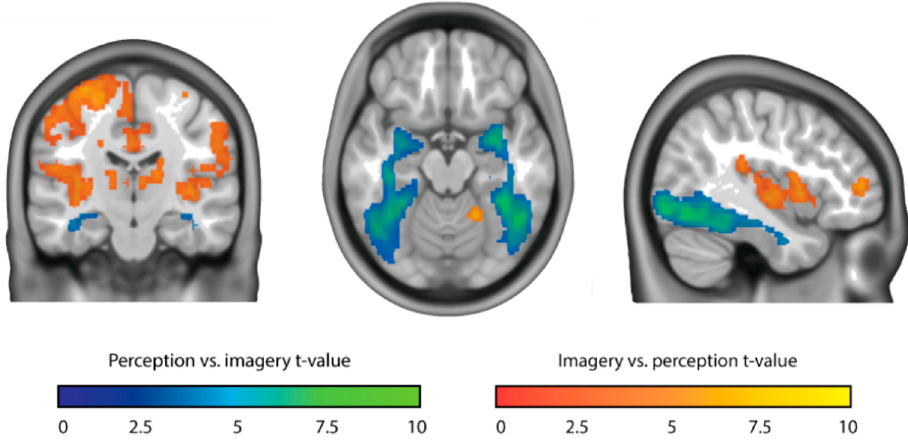
Figure 3. Perception versus imagery. Blue-green colors show t -values for perception versus imagery and red-yellow colors show t -values for imagery versus perception. Shown t -values were significant at the group level. Even though both conditions activated the visual cortex with respect to baseline, stronger activity occurred during perception than imagery throughout the whole ventral visual stream. In contrast, imagery led to stronger activity in more anterior areas, including insula, left dorsal lateral prefrontal cortex, and medial frontal cortex. Reproduced from Reference [27] with permission.